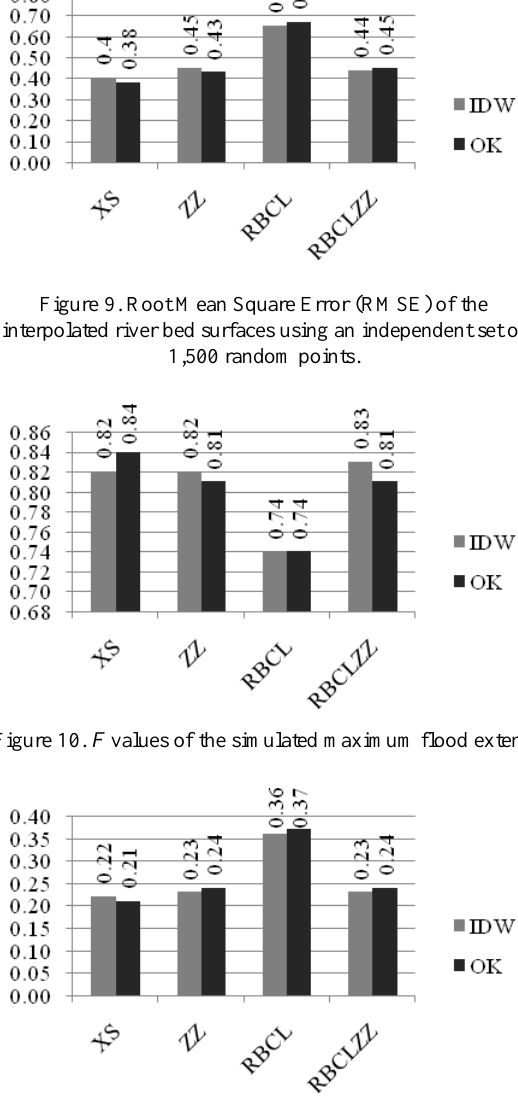
Figure 11. RMSE of simulated maximum flood